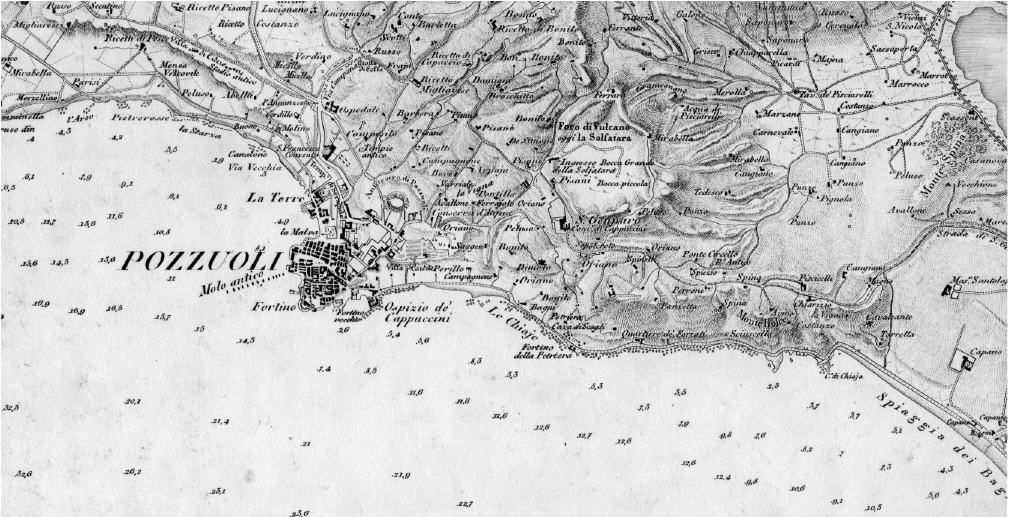
Fig. 7. Detail of the sheet n. 8 of the «Carta dei dintorni di Napoli», scale 1:25000, realized by the Geographer Engeeneers Corp of Naples in the years 1817 and 1819. On this map Visconti planned the levelling operation for studying the Flegraen bradyseism (Private